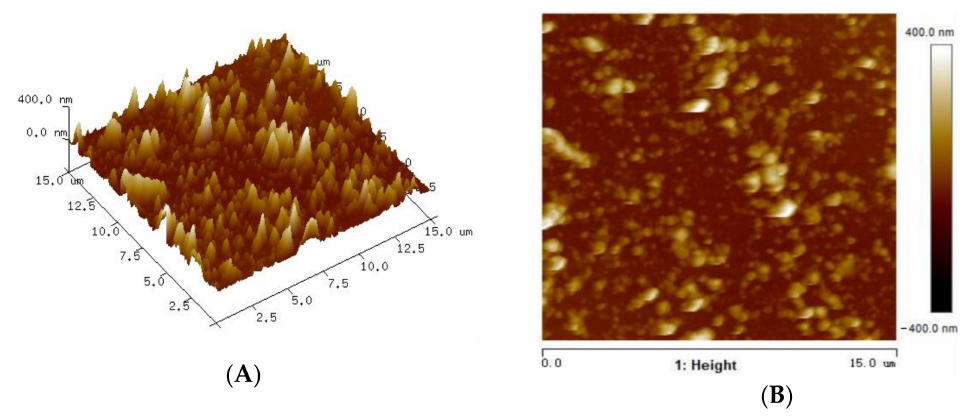
Figure 6. AFM images on a silicon wafer of coating: ( A ) 3D graph and ( B )